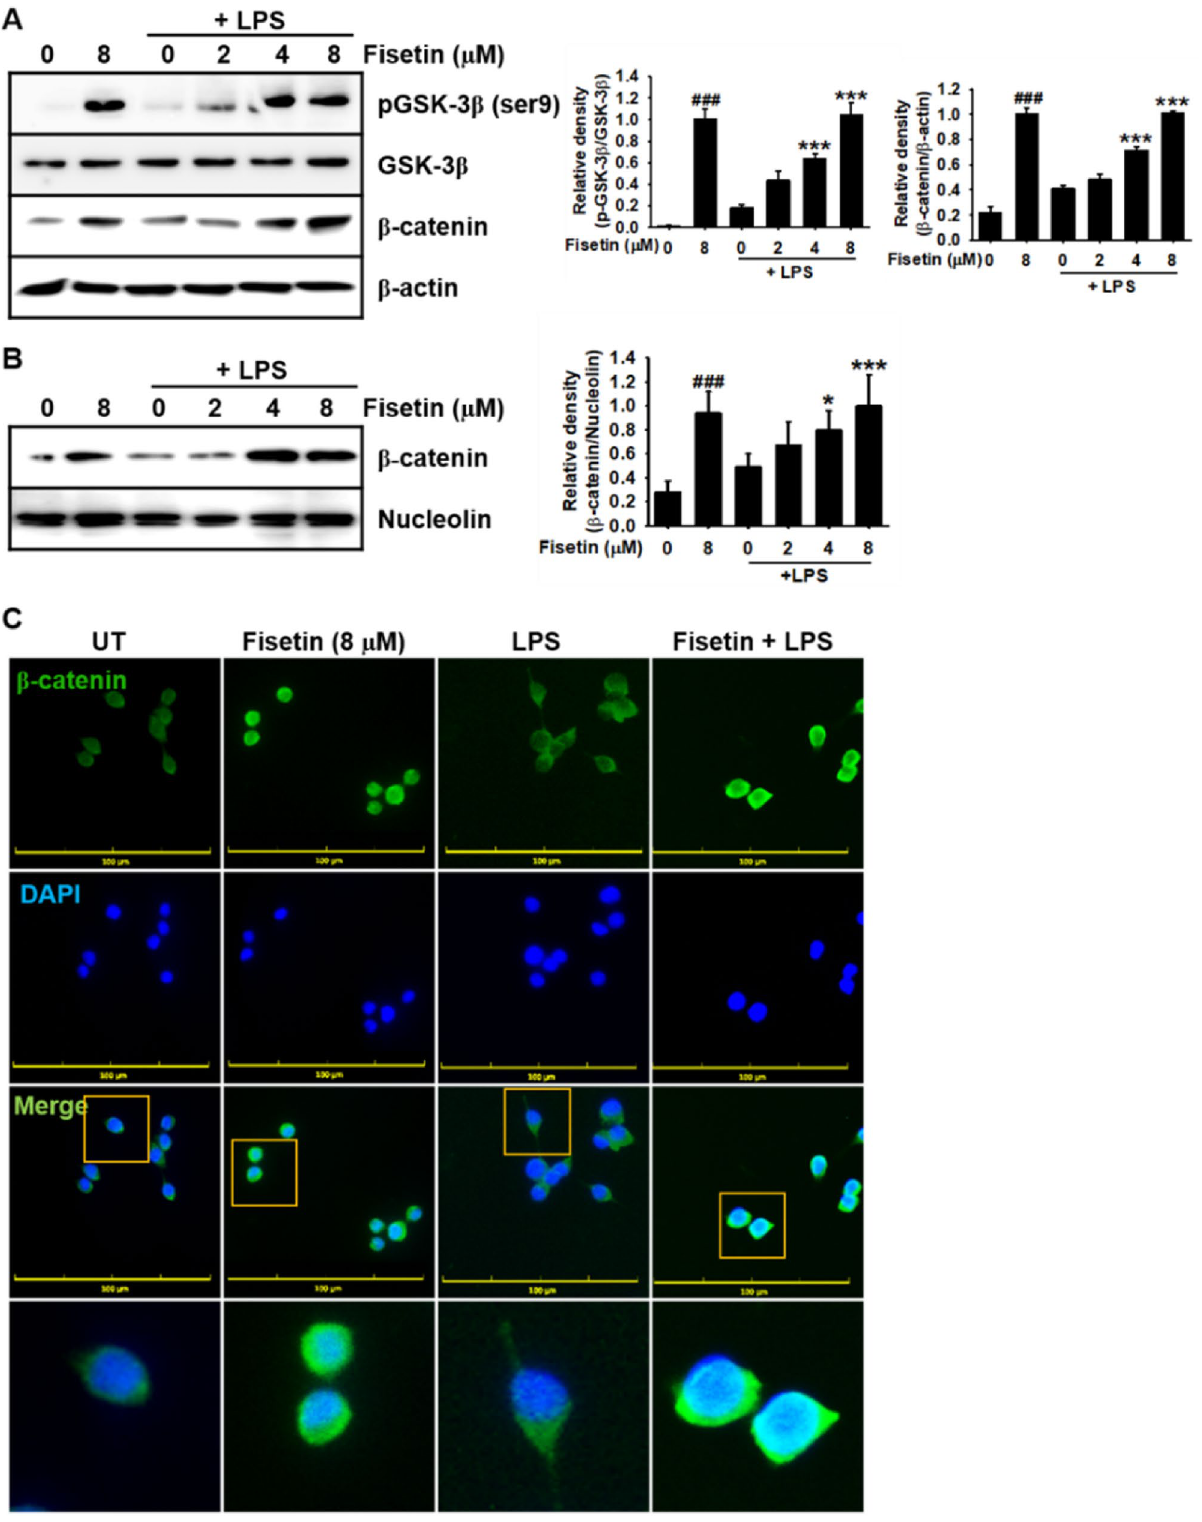
Figure 6. Fisetin promotes the expression of β-catenin and its nuclear translocation in LPS-stimulated RAW 264.7 macrophages. RAW 264.7 macrophages (1 × 10 5 cells/mL) were pretreated with fisetin 2 h prior to LPS treatment (500 ng/mL; 0.5 h). ( A ) Total proteins were isolated and equal amounts of proteins were resolved on SDS–polyacrylamide gels, transferred to PVDF membranes, and probed with antibodies against total GSK-3β, phosphor-GSK-3β (Ser9), and β-catenin. β-Actin was used as an internal control. ( B ) In a parallel experiment, nuclear proteins were isolated and western blotting was performed to verify the nuclear translocation of β-catenin. Nucleolin was used as an internal control. ( C ) Nuclear translocation of β-catenin was detected by immunofluorescence. Each value indicates the mean ± standard error median (SEM), and is representative of the results obtained from three independent experiments. Significant differences among the groups were determined using Student’s t -test ( ### p < 0.001 vs. untreated cells) and one-way ANOVA with Bonferroni correction (*** p < 0.001 and * p < 0.01 vs. LPS-treated cells). UT